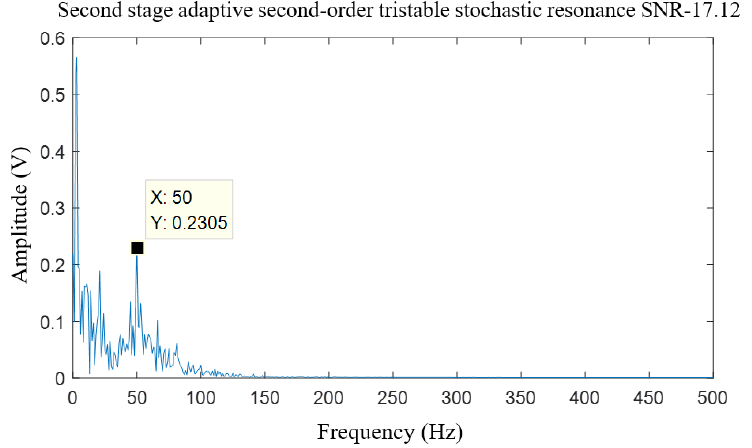
Figure 8. The output spectrum of the second cascade system.